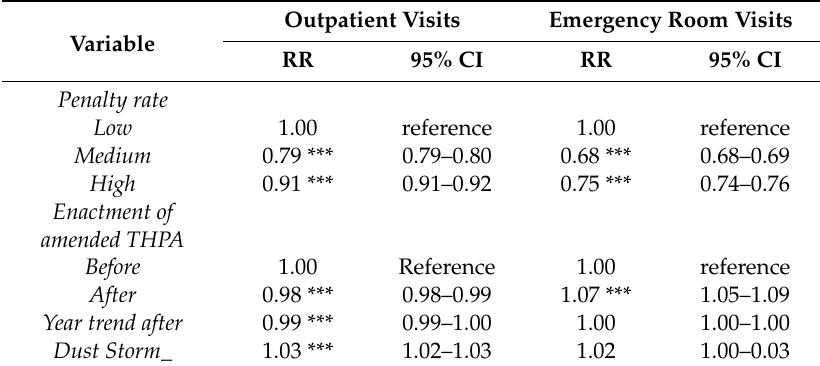
Table 4. Poisson regression analysis of the risk of an outpatient visit and emergency department visits for asthma: the e ff ect of smoking ban